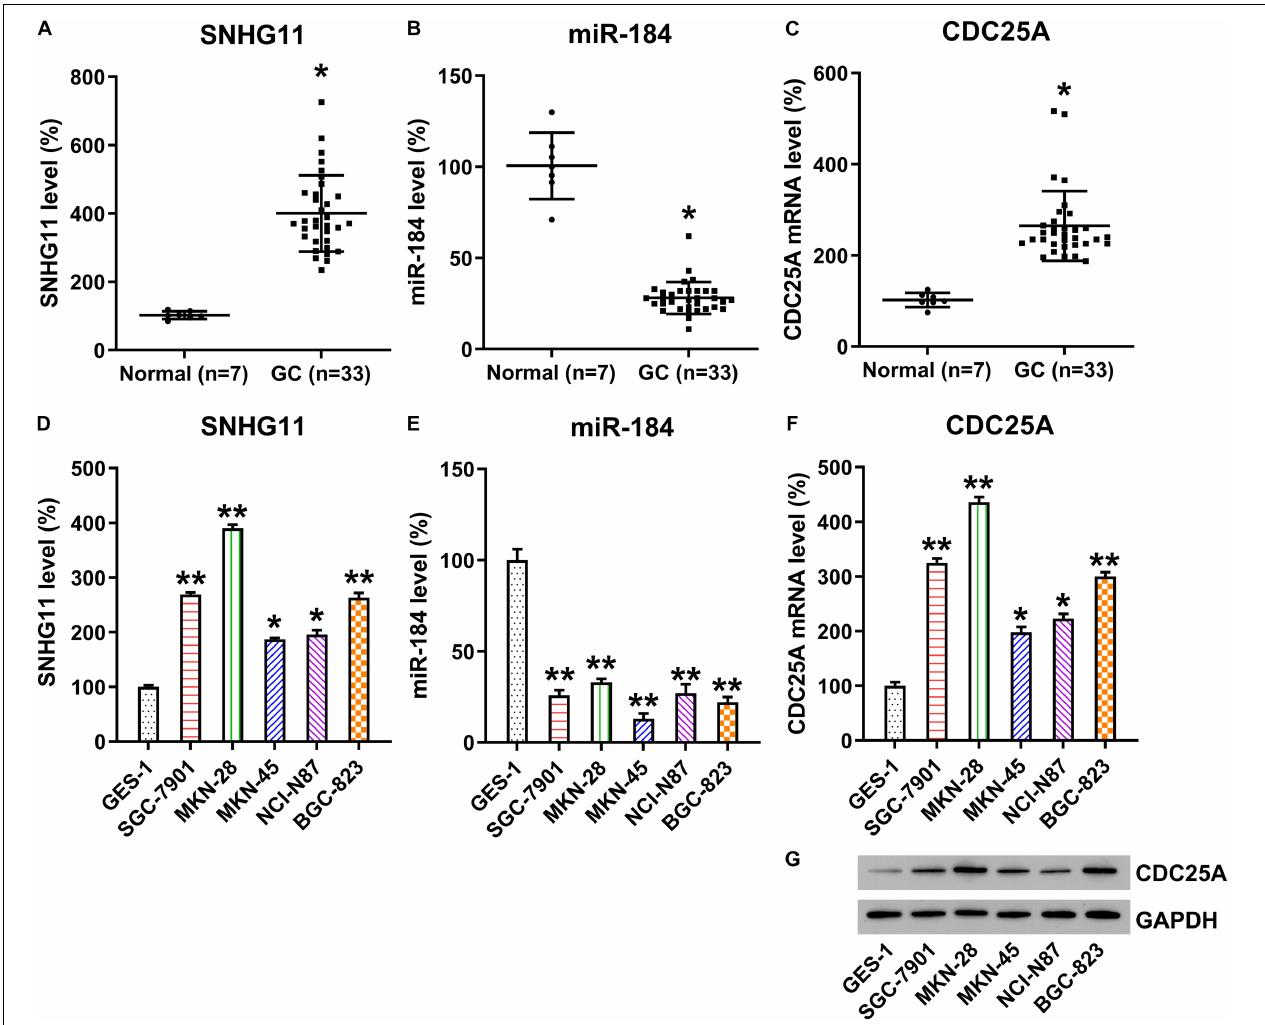
FIGURE 2 | Expressions of SNHG11, miR-184, and CDC25A in GC specimens and cell lines. (A–C) qPCR detection showed expressions of SNHG11, miR-184, and CDC25A in GC specimens ( n = 33) and in specimens from healthy gastric tissue ( n = 7). (D–F) qPCR analysis showed expression levels of HCG11, miR-184, and CDC25A in GC and GES-1 cell lines. (G) Western blotting analysis showed expression levels of CDC25A in GC and GES-1 cells. These data are shown as average ± SD . * P < 0.05, ** P < 0.01 vs. indicated